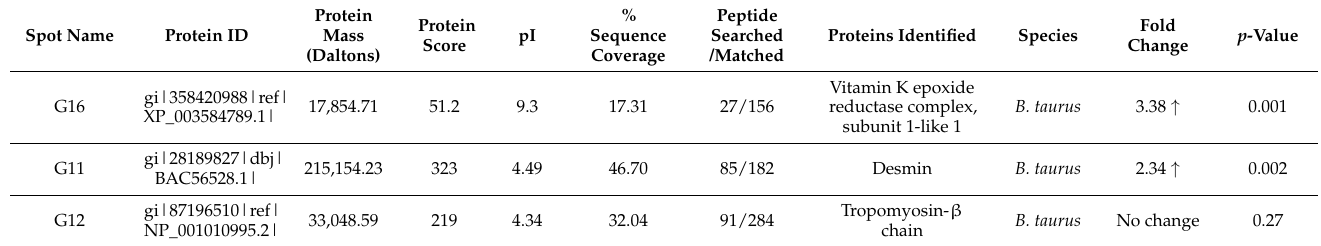
Table 4. Protein spots identified by MALDI TOF/MS of mesenteric artery proteomes. ↑ indicates upregulation of the protein spot. Fold change value was calculated by using the 2D gel image analysis software PDQuest (Bio-Rad) version 7.20. A value of p < 0.05 was considered to be statistically